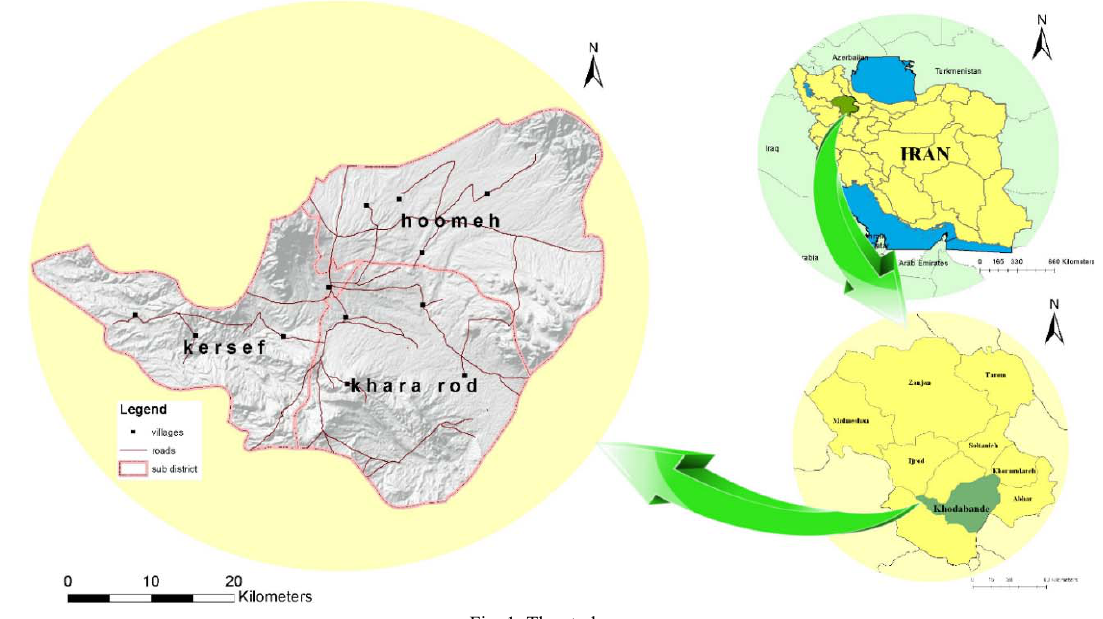
Fig. 1: The study Fig. 1: The study area